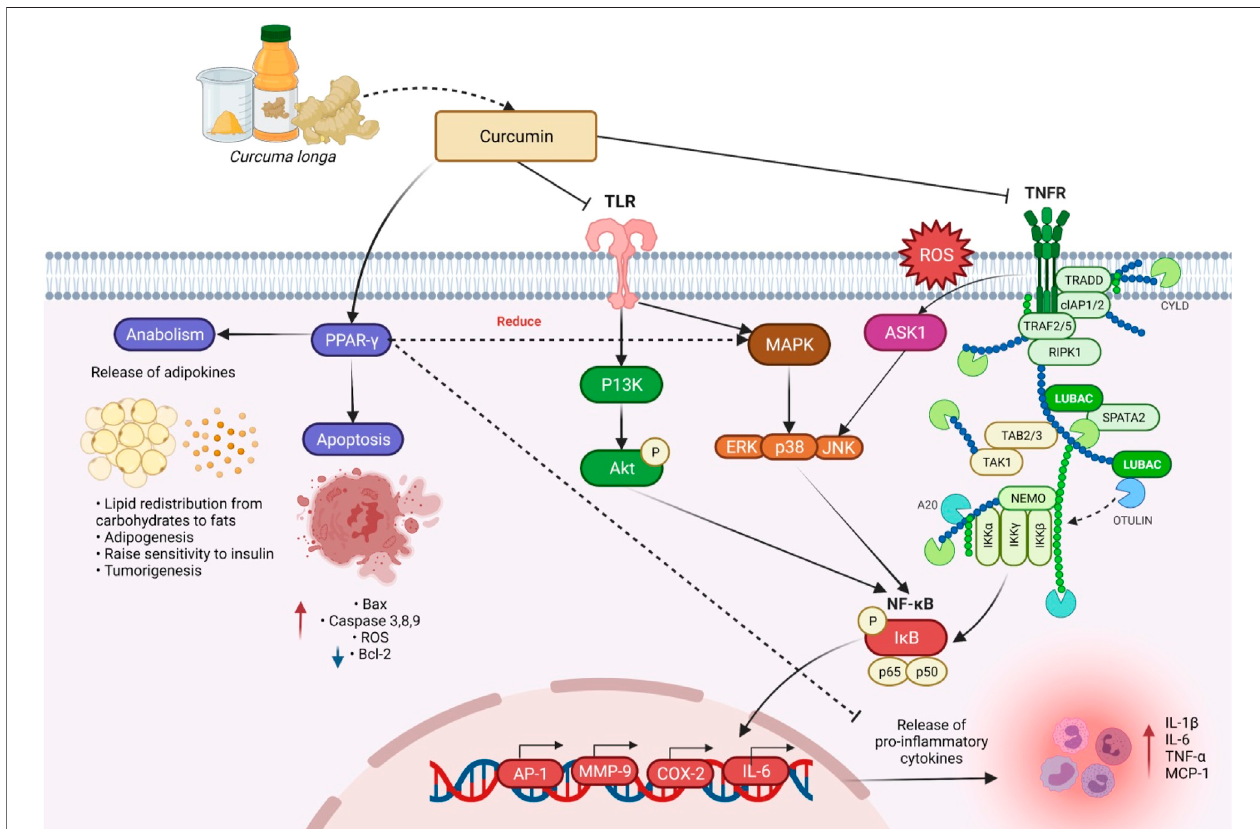
FIGURE 6 | Curcumin ’ s mechanism of action in reducing in fl ammation, anabolism, and apoptosis. By inhibiting the pro-in fl ammatory transcription factor (NF- κ B), and activation of PPAR- γ , curcumin aids in anabolism and apoptosis, suppression of pro-in fl ammatory cytokines, as well as the expression and release of TNF- α . Abbreviations: TLR, Toll-like receptors; TNFR, Tumor necrosis factor receptor; ROS, Reactive oxygen species; TRADD, Tumor necrosis factor receptor type 1- associated death domain protein; CYLD, CYLD lysine 63 deubiquitinase; cIAP1/2, Cellular inhibitor of apoptosis protein 1/2; TRAF 2/5, Tumor necrosis factor receptor-associated factor 2/5; RIPK1, Receptor-interacting serine/threonine-protein kinase 1; LUBAC, Linear ubiquitin chain assembly complex; SPATA2, Spermatogenesis-associated protein 2; NEMO, NF- κ B essential modulator; TAB2/3, TGF-beta activated kinase 1 (MAP3K7) binding protein 2; TAK1, Transforming growth factor- β -activated kinase 1; IKK α , IKK β , and IKK γ , Inhibitory kappa b kinase alpha, beta, and gamma; IkB, Inhibitor of nuclear factor kappa Bv; PPAR- γ , Peroxisomeproliferator-activatedreceptorgamma;P13K,Phosphoinositide3-kinases;Akt,Akstraintransforming;ERK,Extracellular-signal-regulatedkinase;JNK,Jun N-terminalkinase; Bax,Bcl-2-associatedX-protein;AP-1,Activated protein-1; MMP-9,Matrixmetallopeptidase9;COX-2,Cyclooxygenase2;IL-6and1 β ,Interleukin6 and 1 beta; TNF- α , Tumor necrosis factor alpha; MCP-1, Monocyte chemoattractant protein-1.